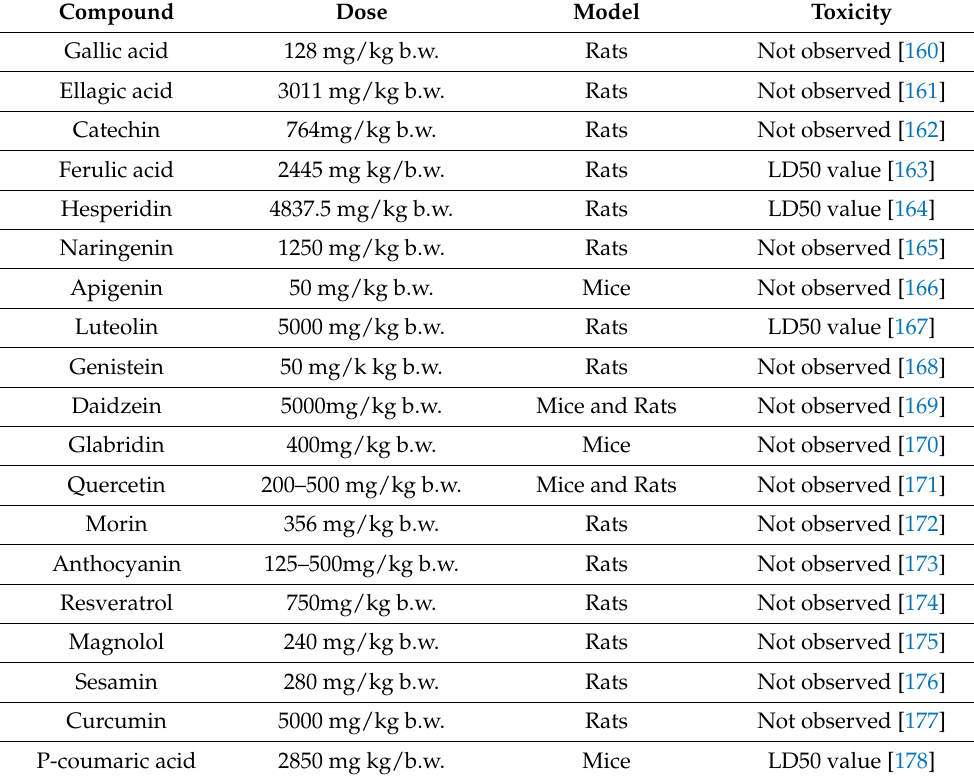
Table 6. Experimental data showing toxicity of